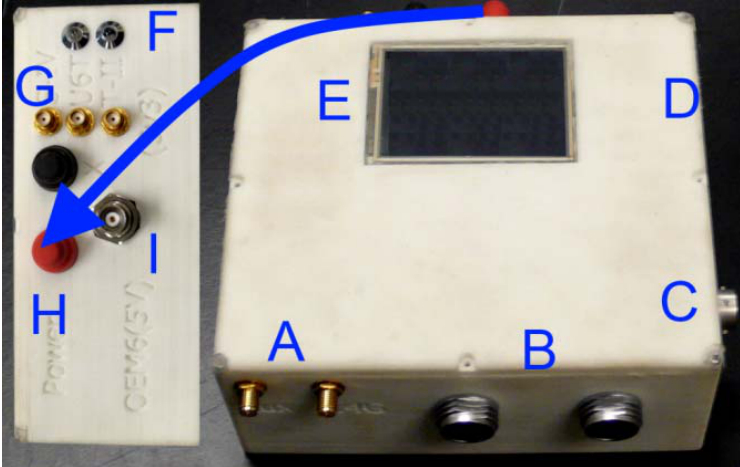
Figure 3. NavCube system assembled in enclosure. Features are as follows—Element A : 2.4 GHz RF link antenna connectors. Element B : External sensor pod data, power and timing connectors. Element C : Charge connector. Element D : SD card socket (side of enclosure). Element E : Touchscreen. Element F : Indicator lights. Element G : High-Sensitivity GPS/GNSS receiver antenna connections. Element H : Control buttons. Element I : GPS, GLONASS multi-frequency receiver antenna connection.